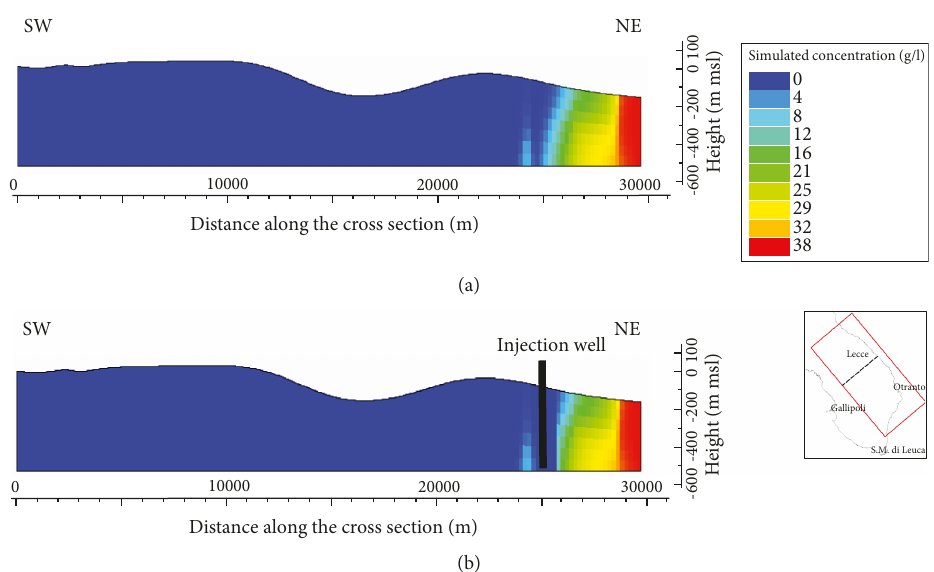
Figure 10: Vertical cross section along the SW-NE pro fi le across one of the injection wells. (a) With injection wells inactivated. (b) With injection wells in